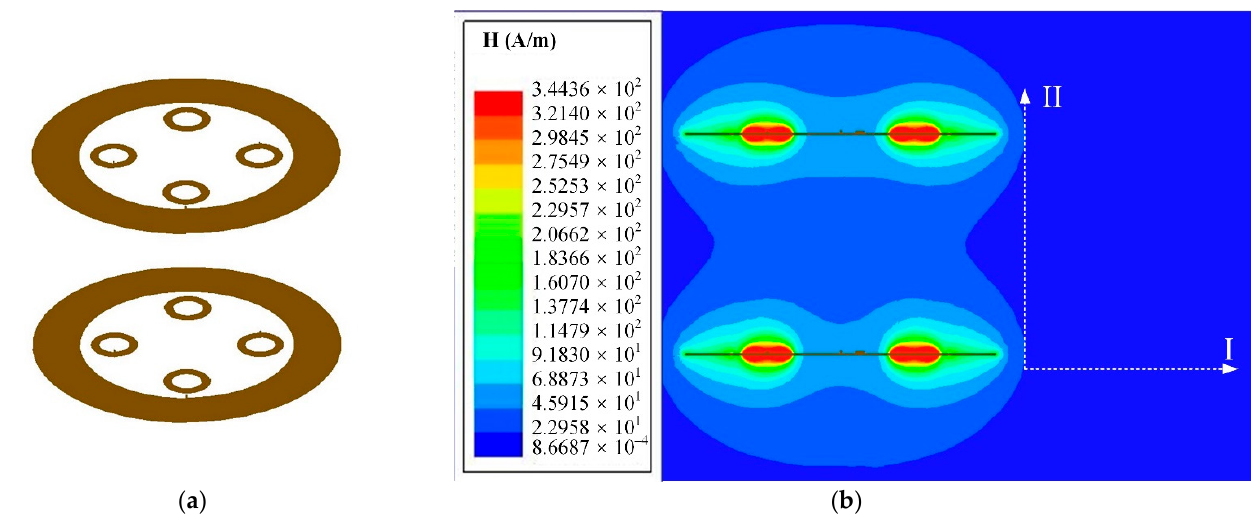
Figure 10. ( a ) The simulation model of the proposed structure; ( b ) the H-field strength of the simulation model from the front view.